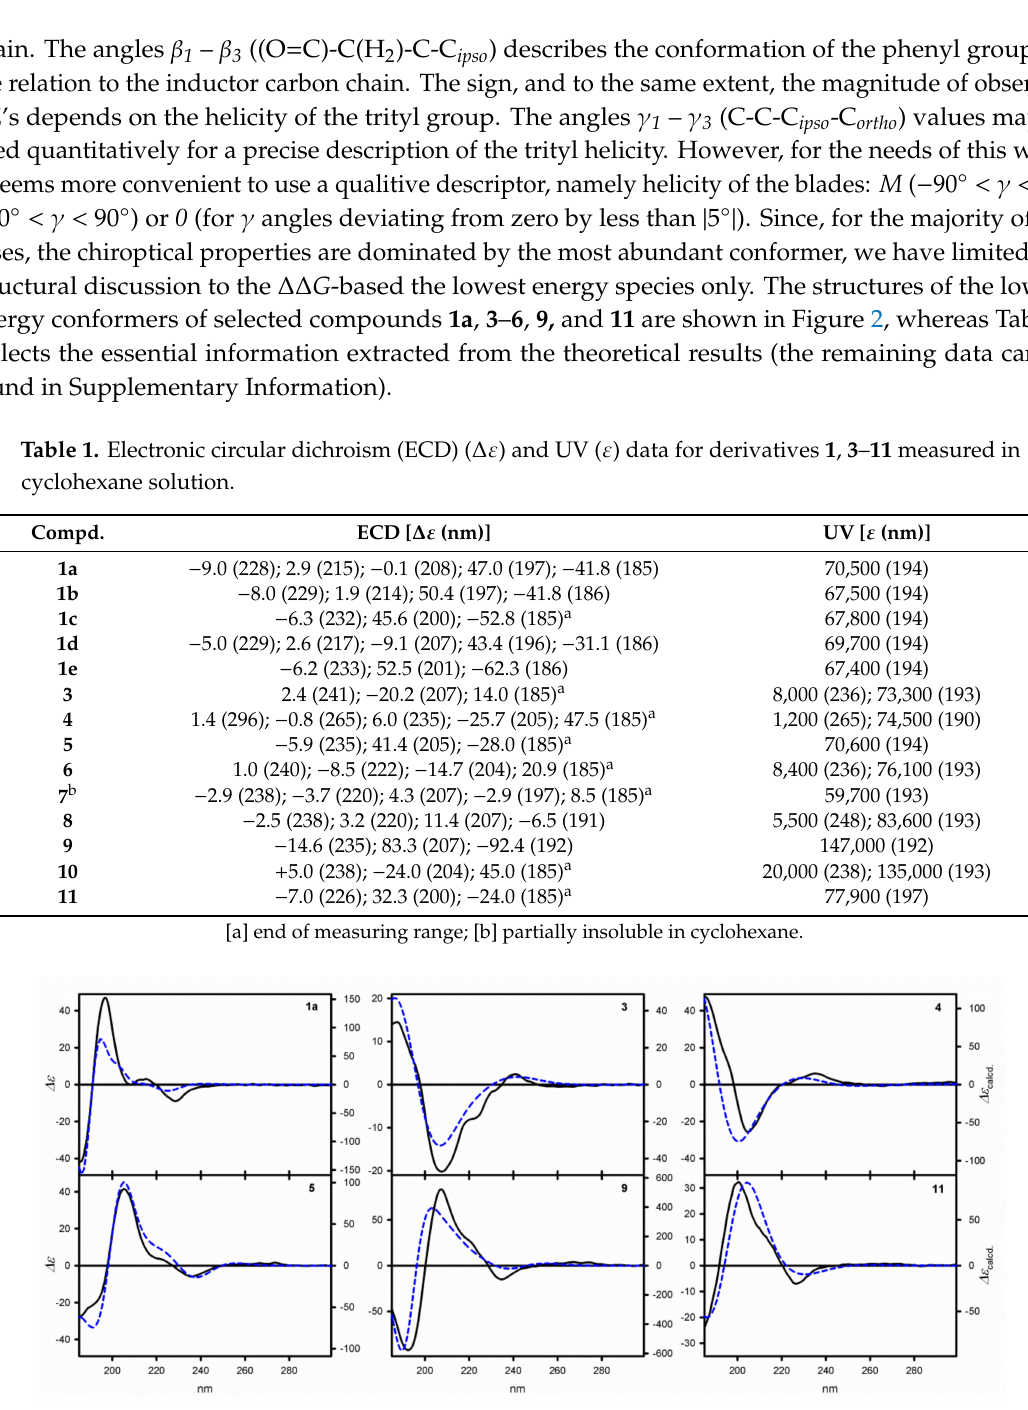
Figure 1. Exemplary ECD spectra of 1a , 3 – 5 , 9, and 11 measured in cyclohexane (solid black lines) and calculated at the TD-CAM-B3LYP / 6-311 ++ G(d,p) level for geometries optimized at the B3LYP / 6-311 ++ G(d,p) level (dashed blue lines). With the exception of 3 , the calculated ECD spectra were Boltzmann-averaged based on ∆∆ G values. Wavelengths were corrected to match experimental UV